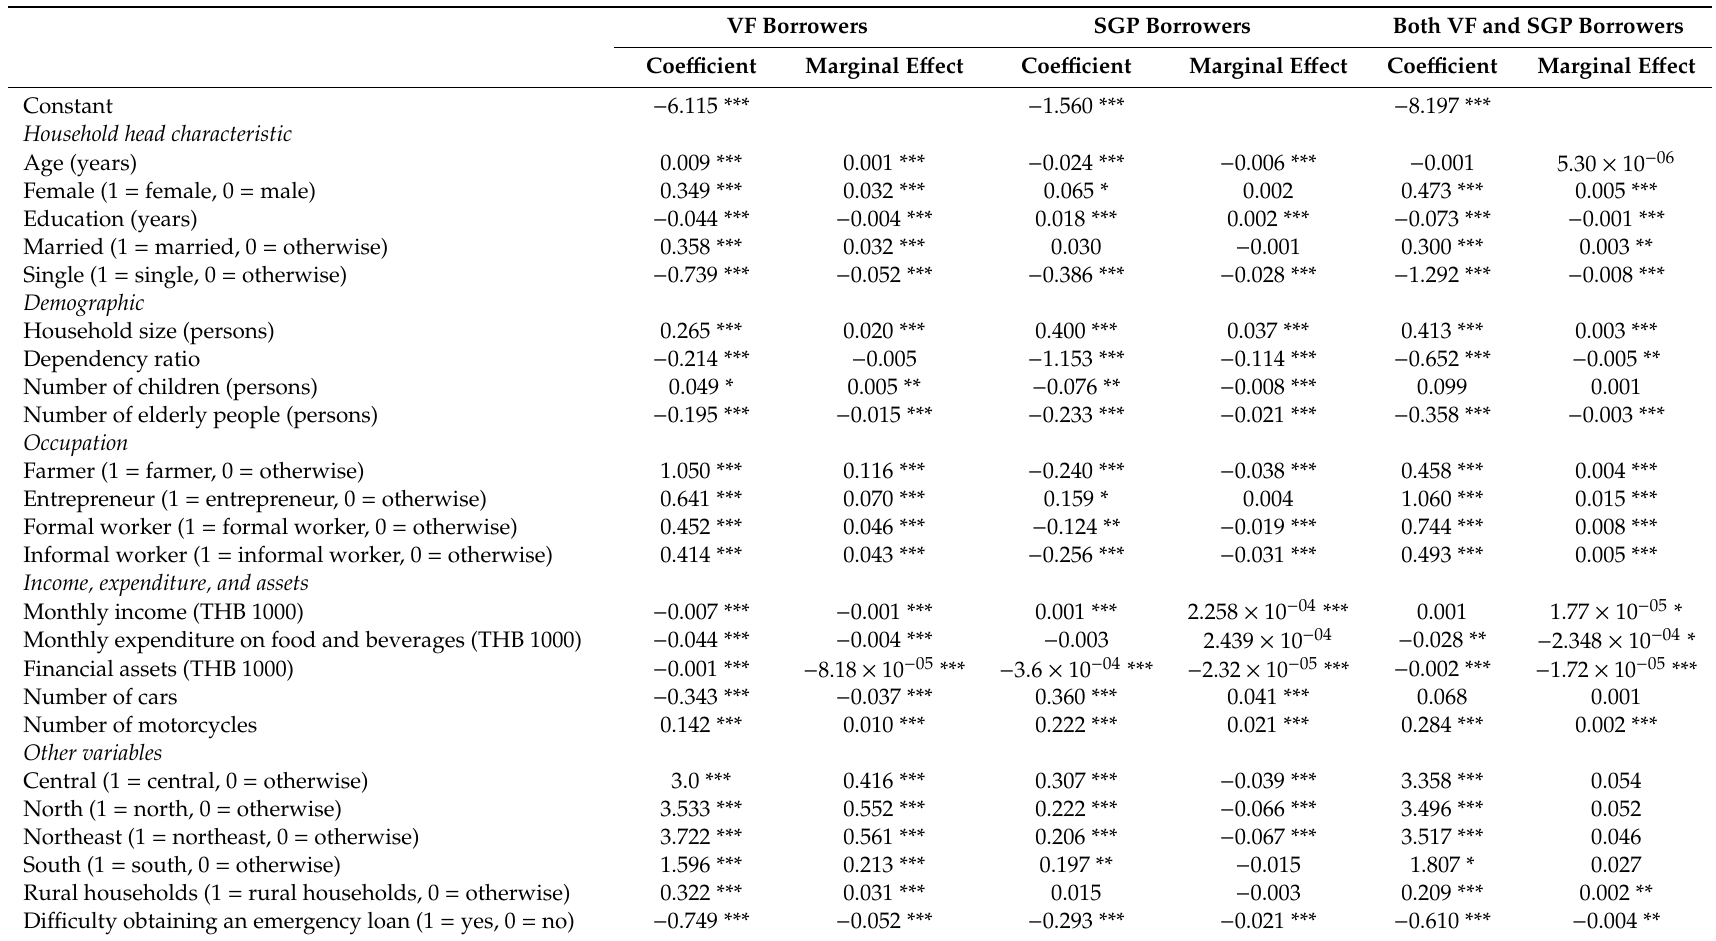
Table 3. Multinomial logit model